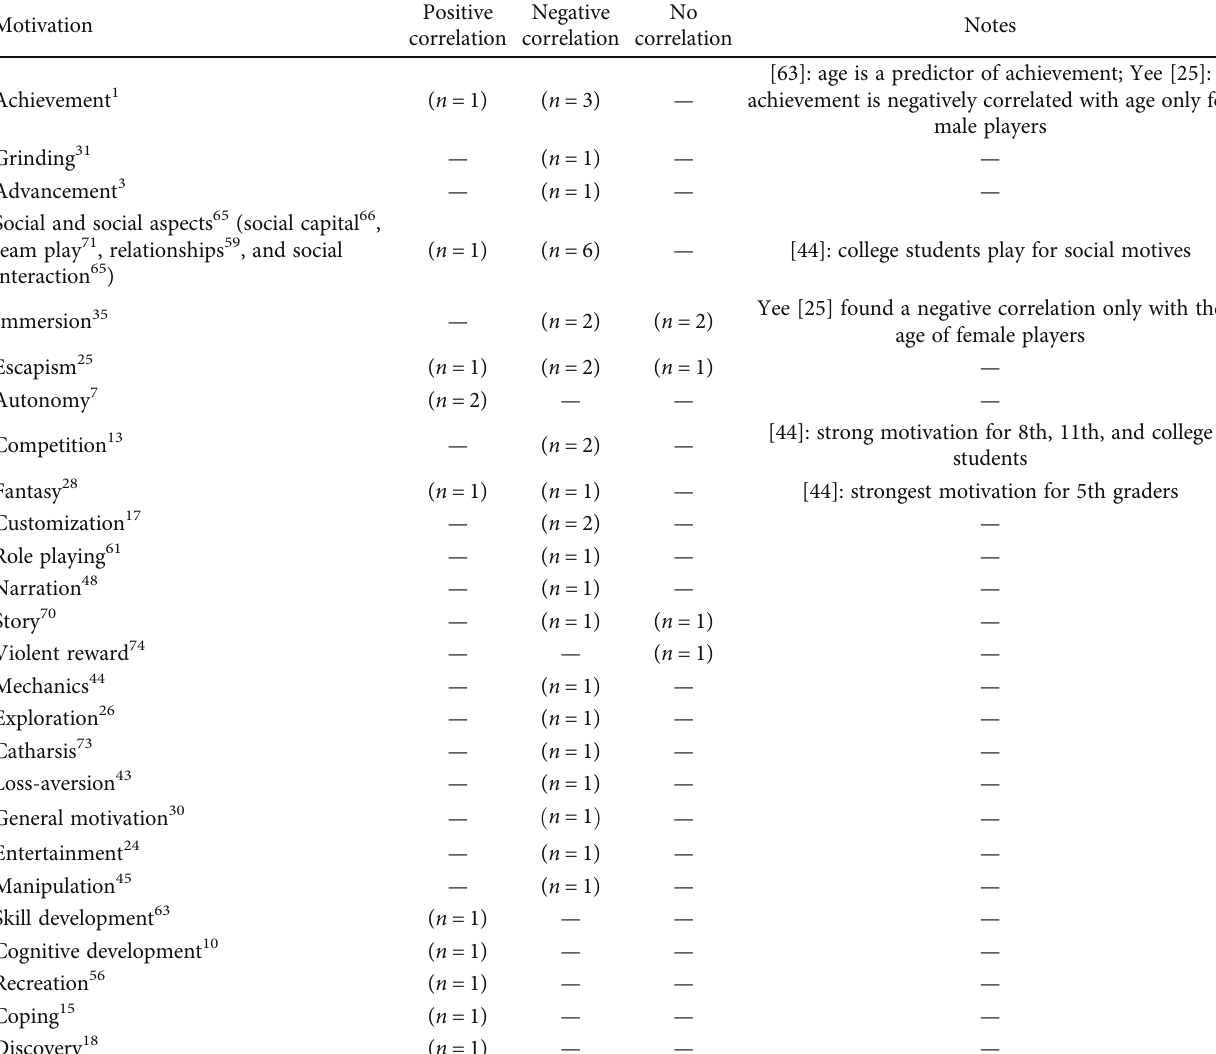
Table 5: The table reports the correlations observed between each gaming motivation and the variable “ Age. ”